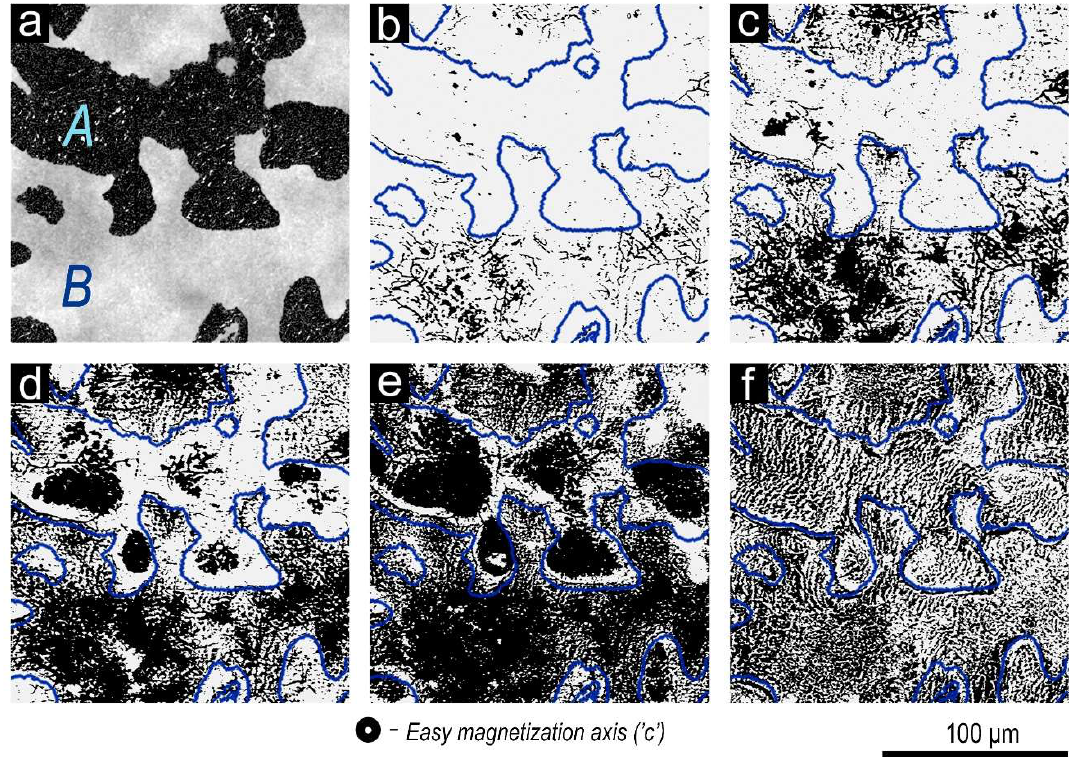
Figure 4. ( a ) Microstructure at the basal plane of the Sm 0.85 Zr 0.15 (Co 0.702 Cu 0.088 Fe 0.210 ) 6.6 sample and ( b – d ) morphology of domain structure (Kerr effect) for the same area upon progressive magnetization reversal from the magnetic saturation state with reverse magnetic fields of ( b ) 10, ( c ) 15, ( d ) 20, and ( e ) 30 kOe, and ( f ) domain structure of sample in the state after demagnetization with an oscillating external magnetic field variable-polarity with a decreasing amplitude.